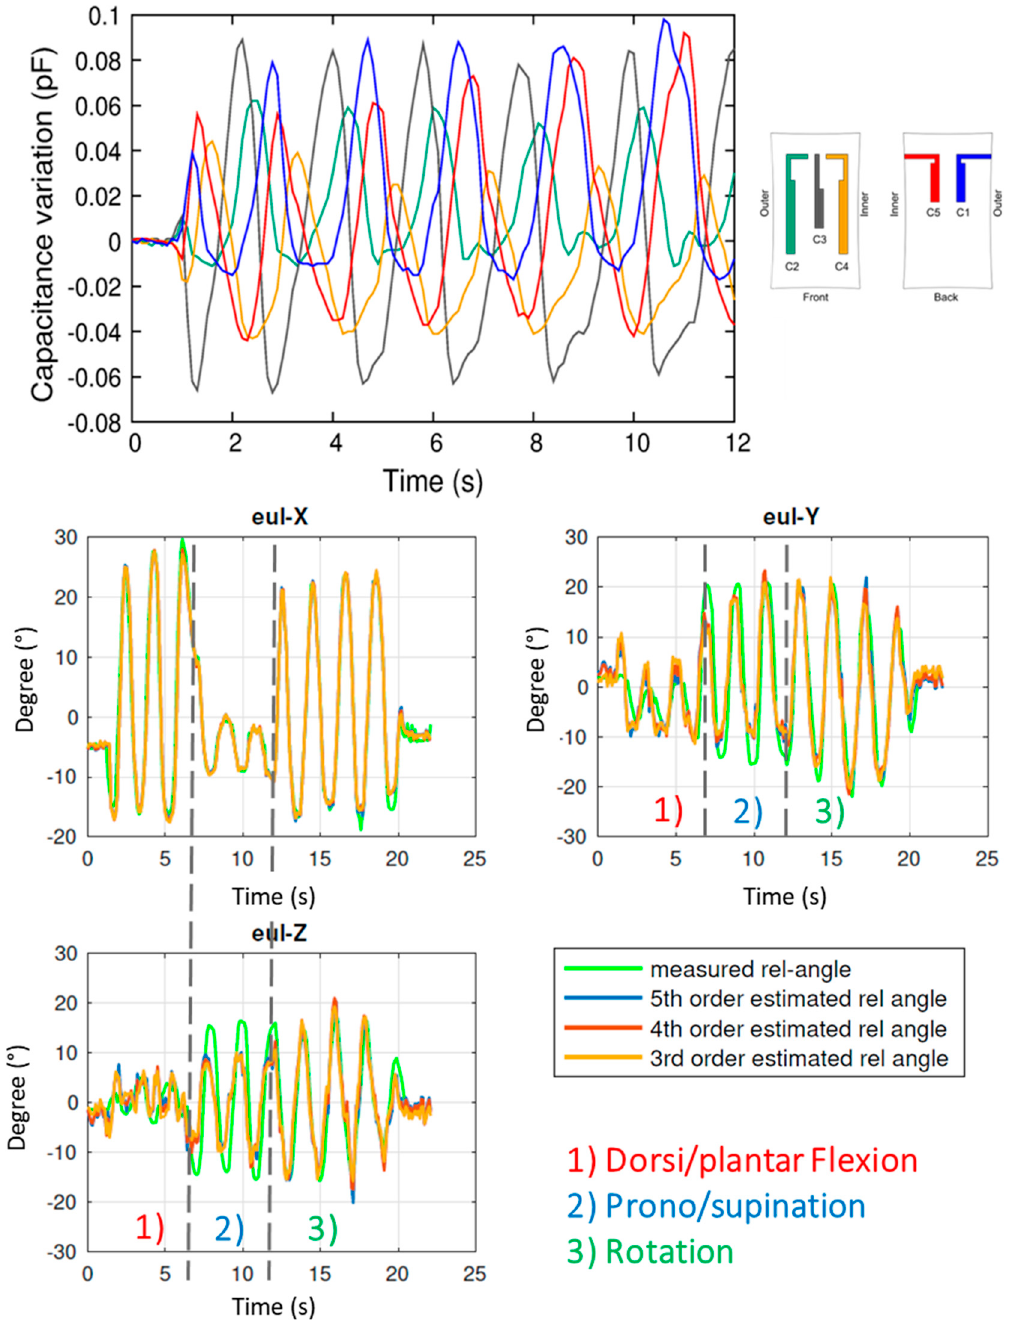
Figure 12. Mixed movement monitoring. Top panel : Raw capacitance variations. Bottom panels : Reconstructed Euler angles compared with the optical tracking system measurements (solid green line). In this case, different movements can be distinguished.